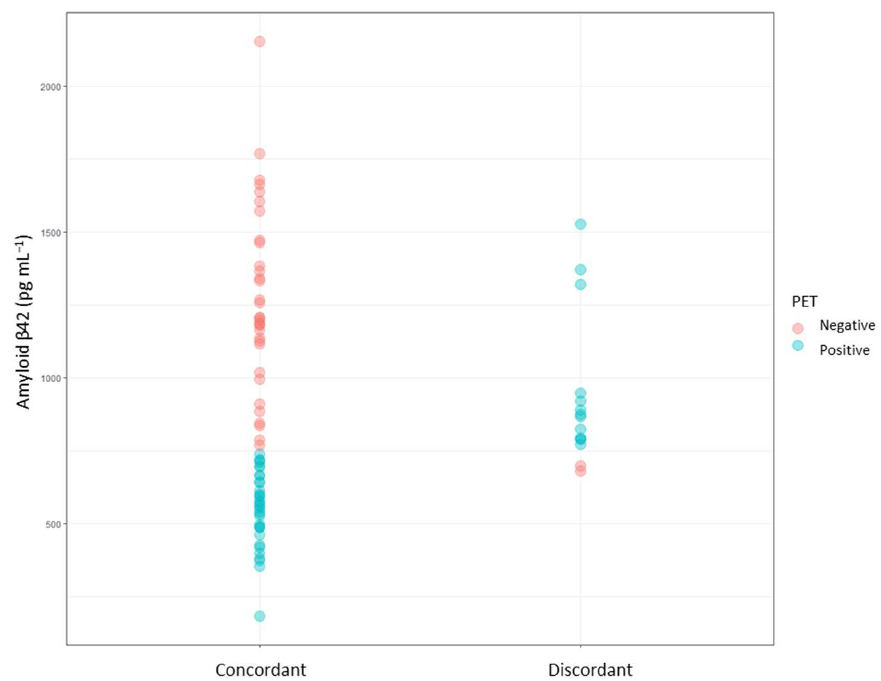
Figure 1. Representation of CSF biomarker level (Aβ1-42) and amyloid PET results for both partici- pant groups (concordant, discordant).